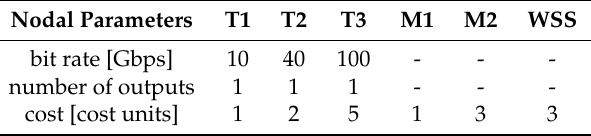
Table 2. Node equipment parameters.